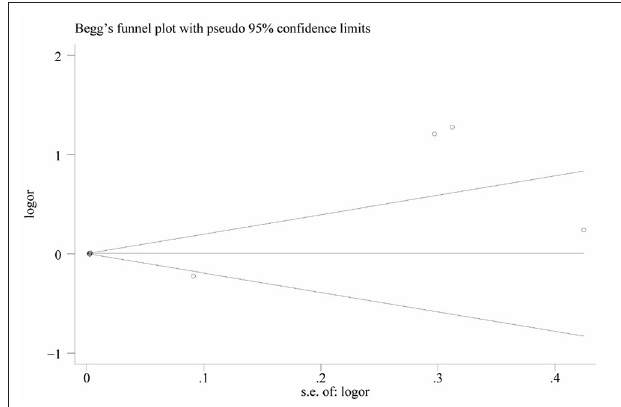
FIGURE 6 | Funnel plot of serum uric acid level as an independent risk factor for